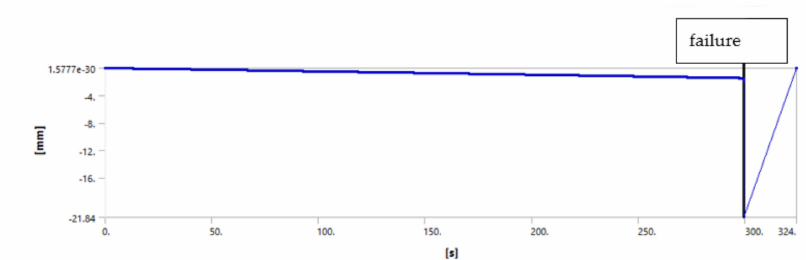
Figure 11. Debonding moment observed on the contact sliding distance showing abrupt change of sliding distance by the blue line at time stamp 299.1 s.